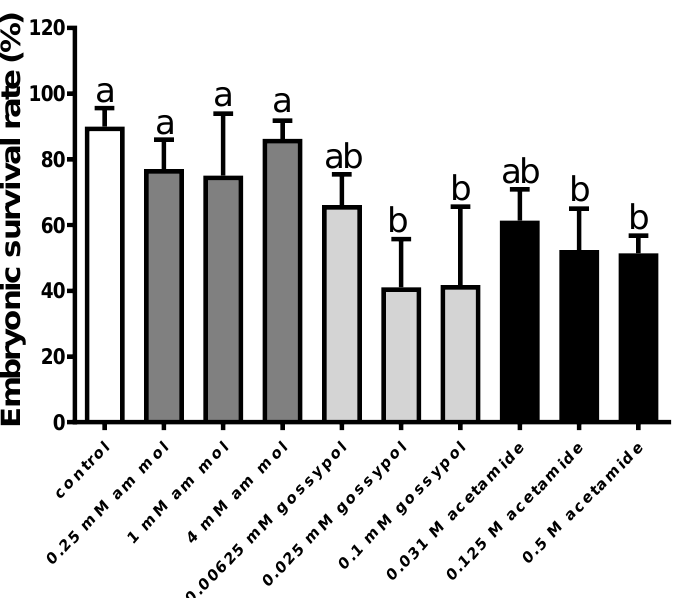
Figure 3. The effect of the enzyme inhibitors added to spermatozoa on the perch sperm motility parameters: ( a ) VCL, curvilinear velocity of sperm, ( b ) VSL, straight-line velocity, ( c ) MOT, motile sperm and ( d ) PRG, progressive sperm. Values are shown as a mean ± SD, p ≤ 0.01, n = 4. Different letters (a, b) indicate the statistically significant differences between the doses of inhibitors ( p ≤ 0.01). The data were analysed using a repeated measure one-way analysis of variance (ANOVA), followed by Tukey’s post hoc test.